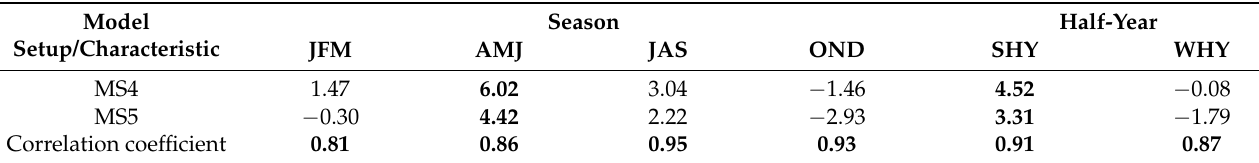
Table 4. Linear trends in the area of 10th ‐ percentile soil drought (% of grid points per 10 years) in the 0–100 ‐ cm soil layer according to model setups MS4 and MS5 and Pearson correlation coefficients between MS4 and MS5 for JFM, AMJ, JAS, OND, SHY, and WHY in the Czech Republic during the